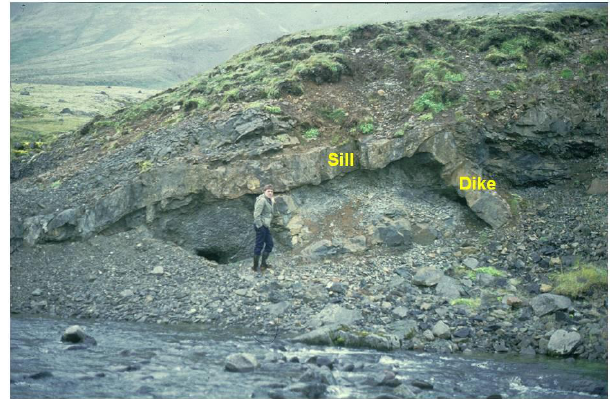
Fig. 7. Dike (inclined sheet) deflected into a sill at a contact between dissimilar layers in the Tertiary areas of West Iceland. The layer below the sill (in front of which the person is standing for scale) is softer (more compliant) than the basaltic lava flow on the top of the sill.